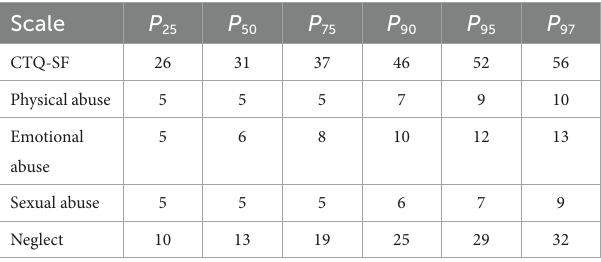
TABLE 6 Normative data of the alternative